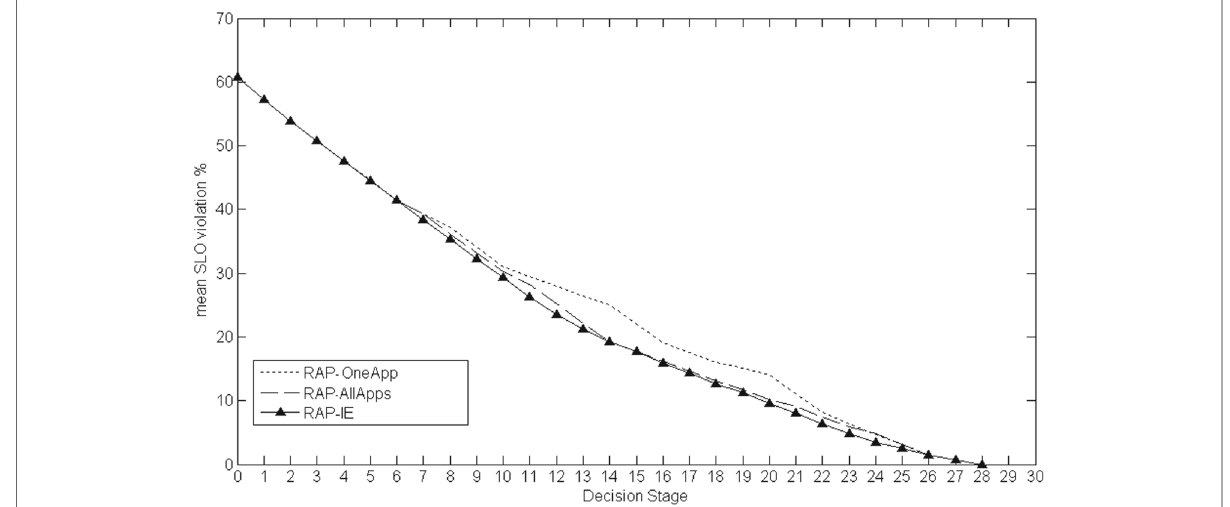
Fig. 6 Effect of similarity in service